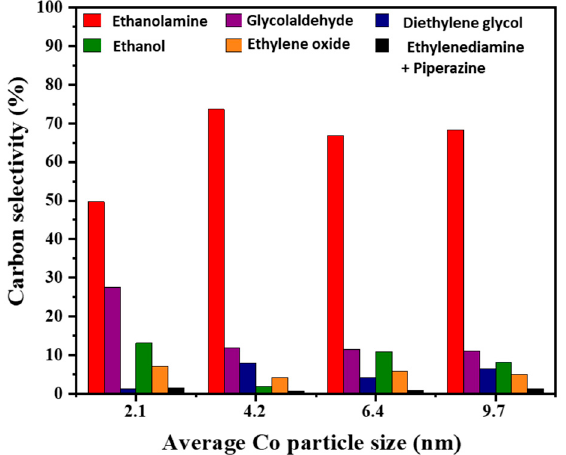
Figure 1. Effects of Co particle size on the carbon selectivity of ammonolysis of ethylene glycol on Co/ γ -Al 2 O 3 catalysts (453 K, 0.13 mol/L ethylene glycol in tetrahydrofuran solution, 0.6 MPa NH 3 , 3.0 MPa H 2 , controlled at ~20% conversion).